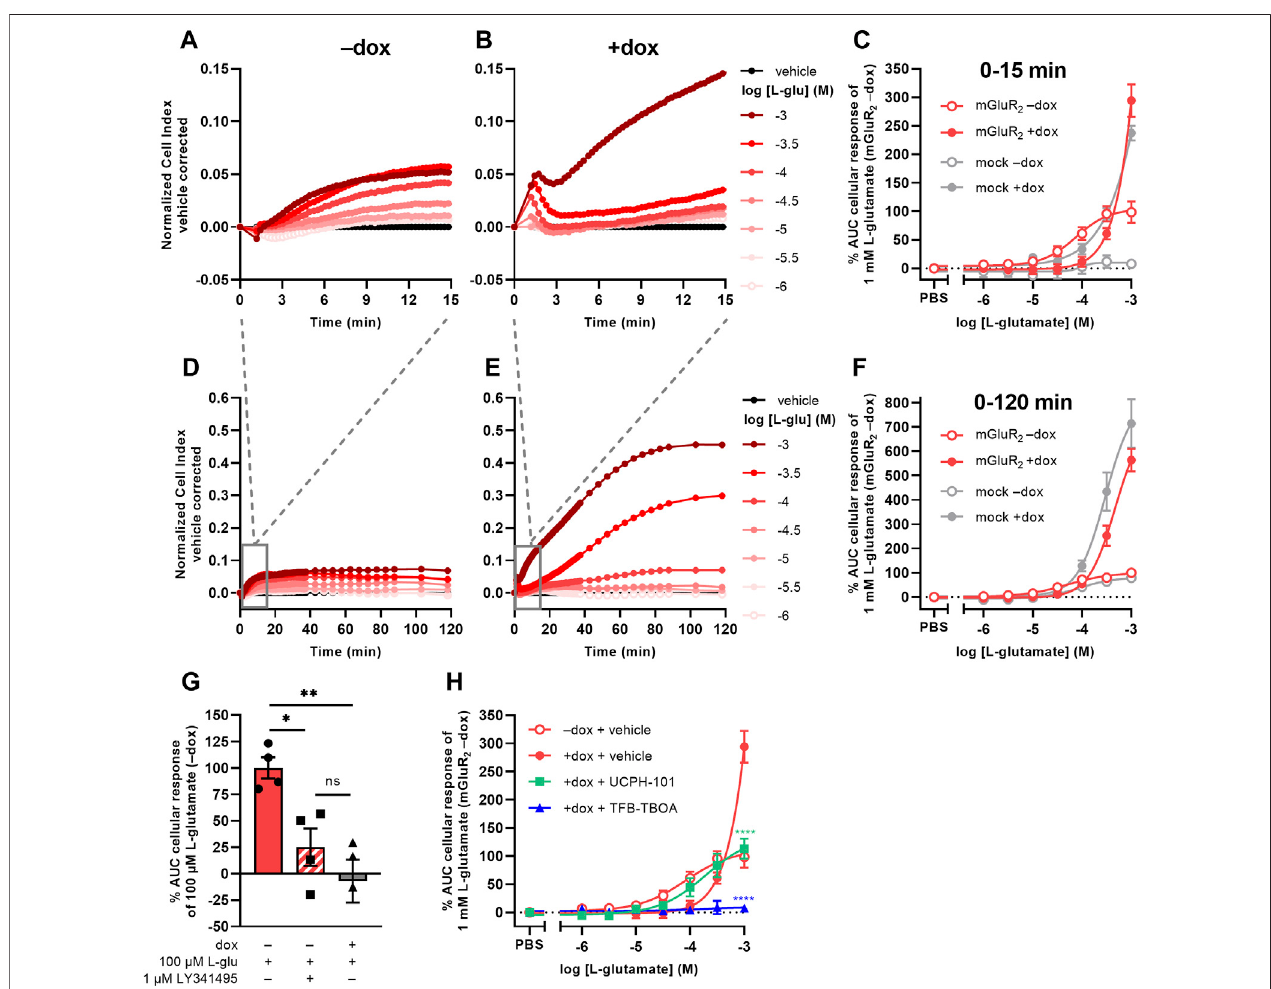
FIGURE 1 | L-glutamate induces distinct mGluR2- and EAAT1-mediated responses in a TRACT assay. (A,B,D,E) Vehicle-corrected normalized Cell Index (nCI) tracesofthe fi rst 15 min (A,B) or 120 min (D,E) after stimulation ofcellswith vehicle (PBS) orL-glutamate (L-glu) intheabsence ( − dox) (A,D) or presence (+dox) (B,E) of doxycycline, shown as the mean of a representative experiment performed in duplicate. (C,F) Combined concentration-response curves of L-glu on JumpIn-EAAT1- mGluR 2 cells (±dox, red) and mock-transfected JumpIn-EAAT1 cells (mock) (±dox, grey). (G) Cellular response of 100 μ M L-glu on JumpIn-EAAT1-mGluR 2 cells (±dox) pretreated for 1 h with vehicle (PBS/DMSO) or 1 µM LY341495. (H) Combined concentration-response curves of L-glu on JumpIn-EAAT1-mGluR 2 cells (±dox) pretreatedfor1 hwithvehicle(PBS/DMSO) (dataderivedfrom Panel1C ),10 µMUCPH-101or10 µMTFB-TBOA.CellularresponseisexpressedasthenetAUCofthe fi rst 15 min (C,G,H) or 120 min (F) after L-glu stimulation. Data are normalized to the response of 1 mM (C,F,H) or 100 µM (G) L-glu on JumpIn-EAAT1-mGluR cells. Data are shown as the mean ± SEM of three or four individual experiments each performed in duplicate. ns = not signi fi cant, * p < 0.05, ** p < 0.01, *** p < 0.001, **** p < 0.0001; one-way ANOVA with Tukey ’ s post-hoc test (G) or two-way ANOVA with Š ídák ’ s post-hoc test compared to vehicle-treated +dox cells (H) .